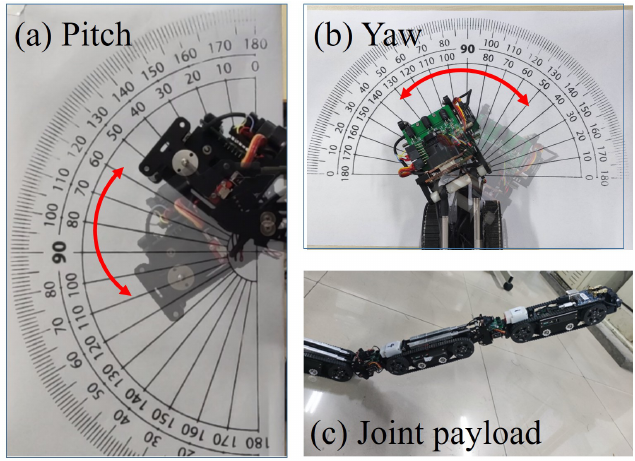
Figure 12. Pitch and yaw angles of the joint and maximum payload.